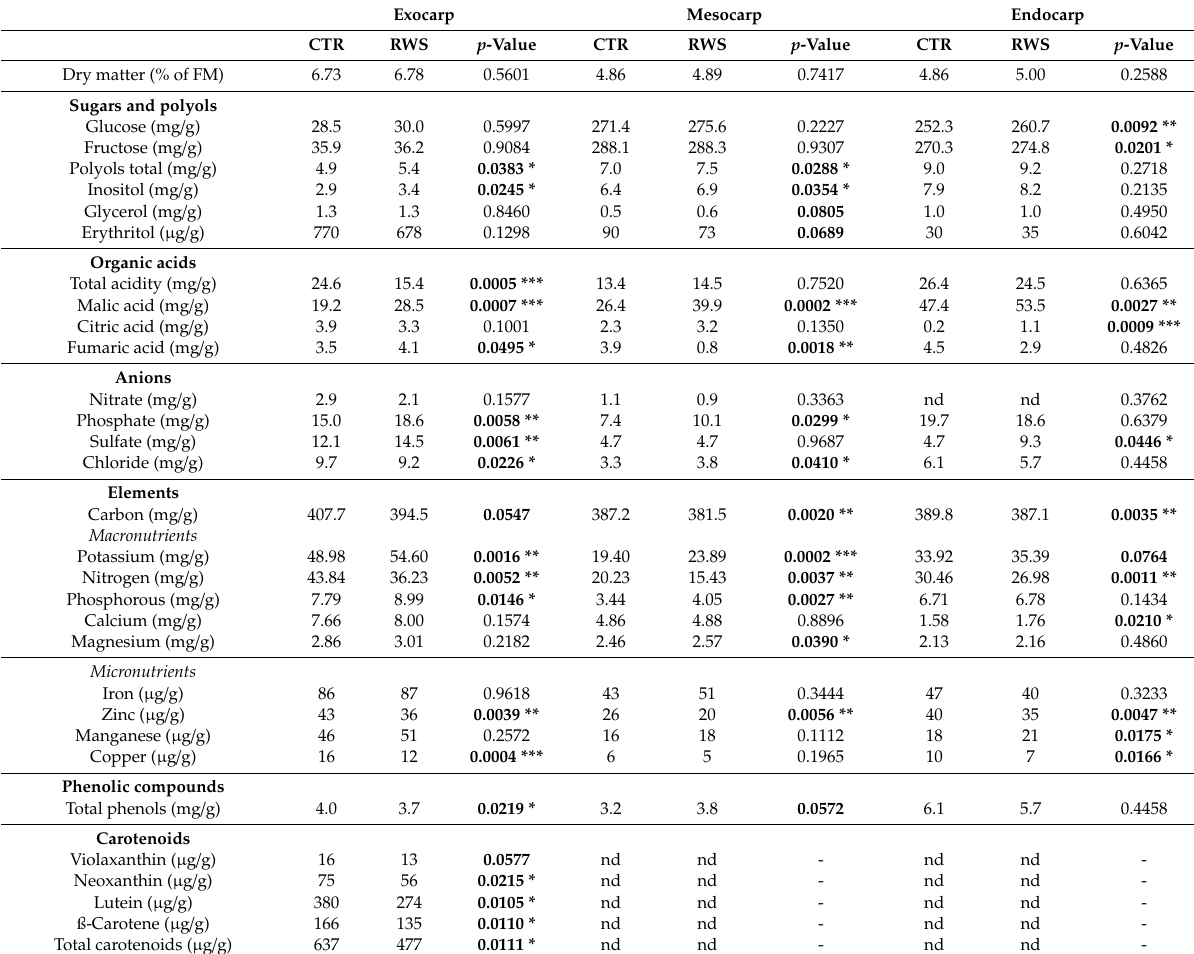
Table 4. Influence of reduced water supply on the dry matter-related levels of certain constituents of pickling cucumber fruit compartments from a greenhouse experiment in summer 2015. Linear mixed model, t -test, p -values: < 0.05 (*), < 0.01 (**) and < 0.001 (***); nd = not determined, CTR: Control treatment with full water supply, RWS: Reduced water supply treatment (60% of the water amount of the